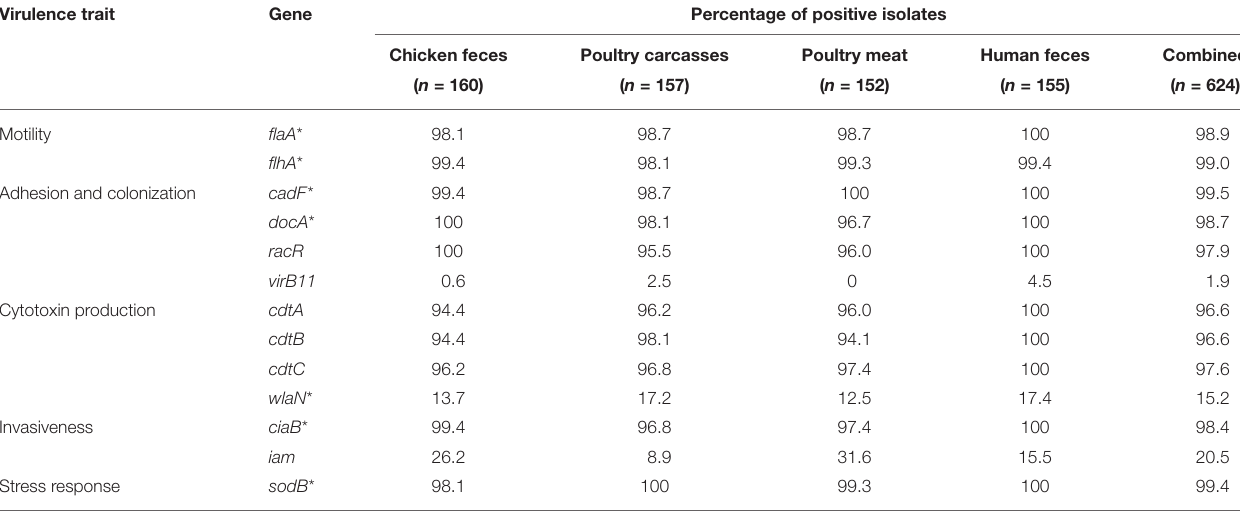
TABLE 1 | Distribution of virulence associated and environmental resistance genes in C. jejuni